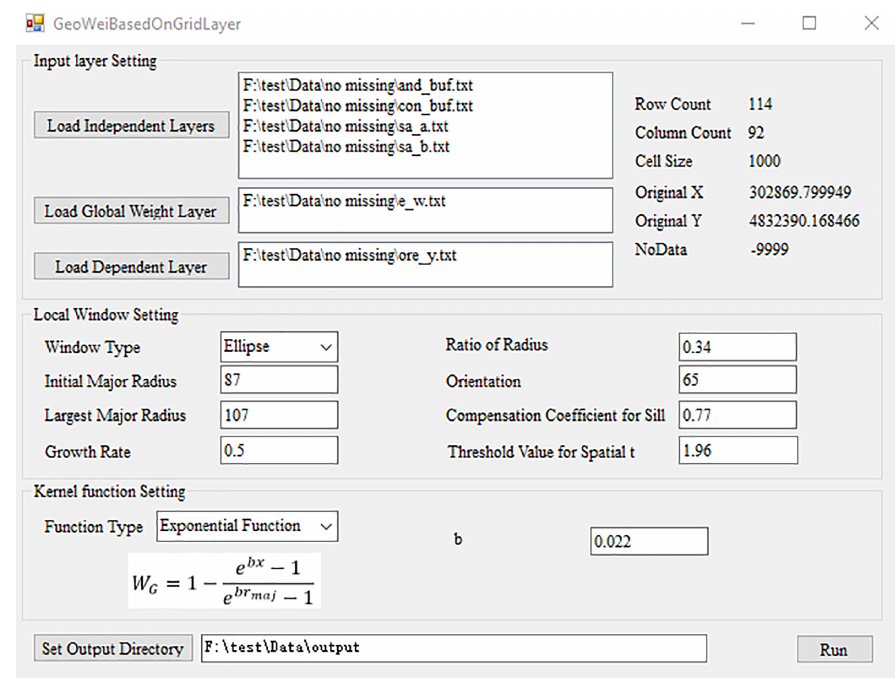
Figure 3. User interface